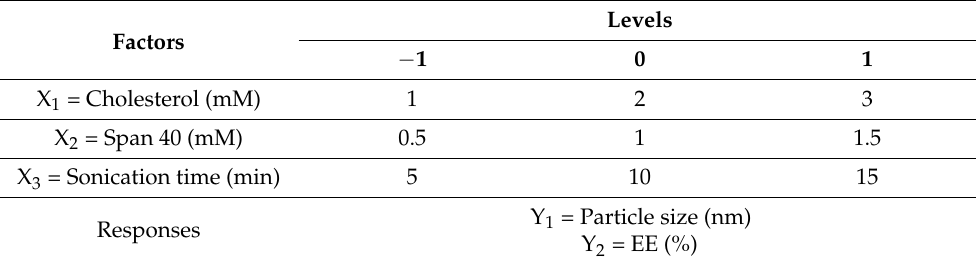
Table 5. Factors and response variables for Box-Behnken design.